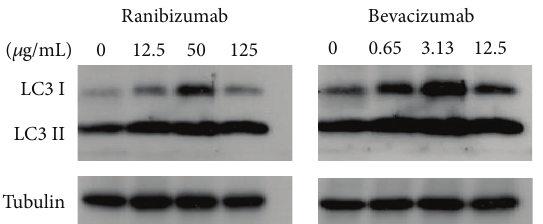
Figure 9: Induction of autophagy by ranibizumab and bevacizumab in L929